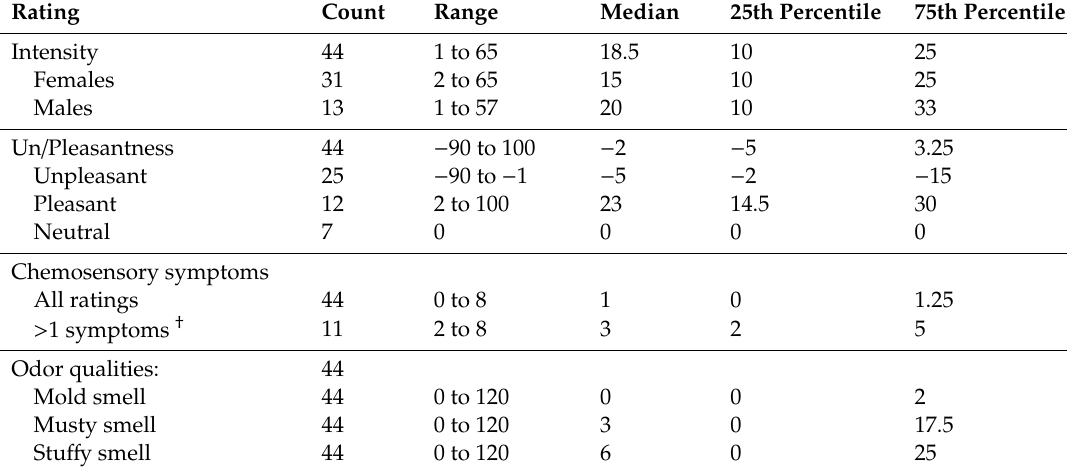
Table1. Individualratingsby44subjectssni ffi ngfromabagcontaining50ng / m 3